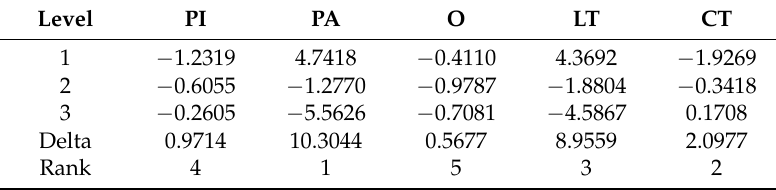
Figure 9. SN ratio analysis based on RMSE response. The level corresponding to the maximum value of mean of SN ratios is selected for each factor. Table 6. Response table for signal-to-noise ratio: smaller the